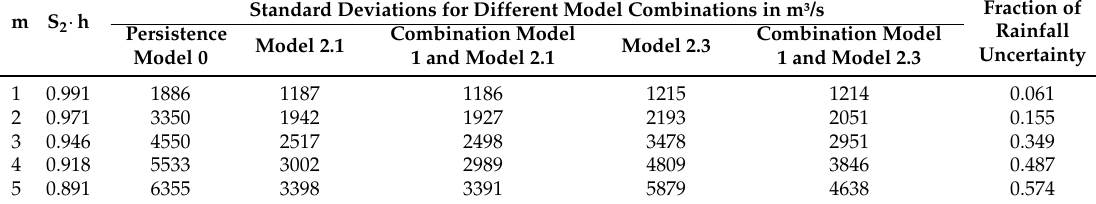
Table 3. Effect of rainfall forecast on forecast accuracy for combinations of model class 2 type 2.1 and 2.3.